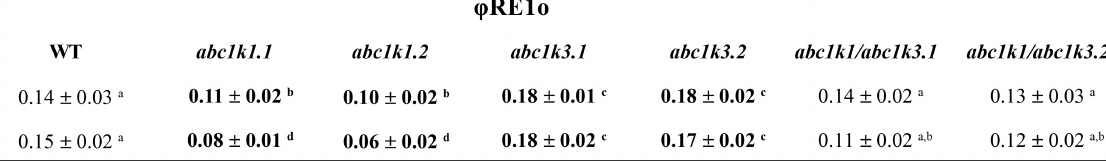
FIGURE 4 | High light as a moderate impact on photosynthetic electron transport fluxes in abc1k1/abc1k3 . Fully expanded leaves from Wild type (WT), abc1k1.1, -2, abc1k3.1, -2, and abc1k1/abc1k3.1, -2 plants were collected under moderate light conditions (120 µ mol of photons m − 2 s − 1 ) (ML) and after 3 h of high light (500 µ mol of photons m − 2 s − 1 ) (HL). (A) Normalized area (Area/F V ) above the chlorophyll fluorescence induction curve measured after 15 min of dark incubation. This value estimates the number of available electron carriers per PSII reaction center. (B) Quantum electron transport yield from Q A to PQ pool ( (cid:56) ET2o), and (C) until the PSI electron acceptors ( (cid:56) RE1o). These measures were performed with Handy-PEA (Hansatech Instruments). Whiskers and box plot shows the minimum, first quartile, median, average, third quartile, and maximum of each data set ( n = 12 biologically independent samples). Superscript letters are used to indicate statistically different groups by paired Student’s t -test ( p <